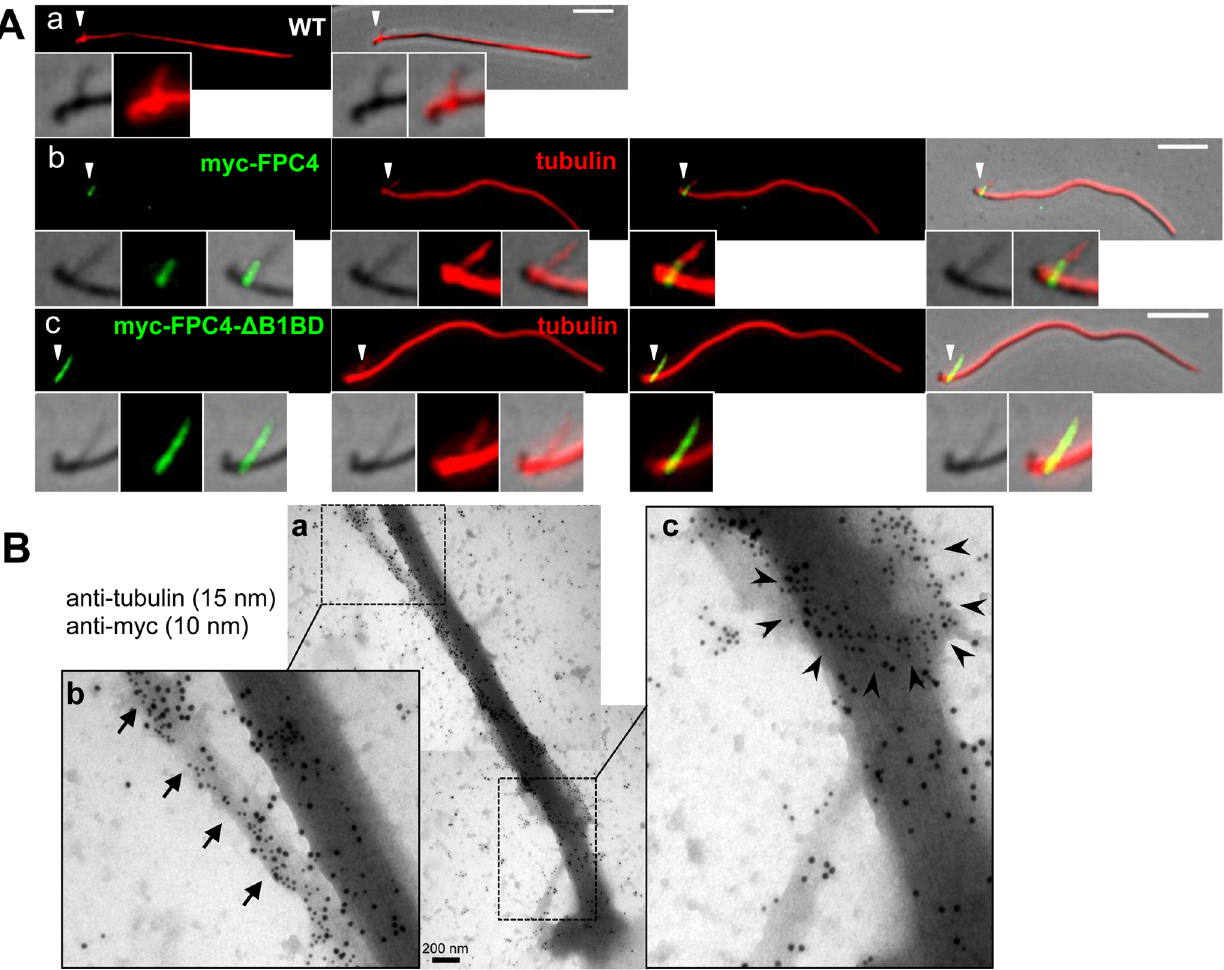
Fig 8. FPC4 binds to the remnant MtQ complex of isolated flagella. (A) Co-labellingof myc-taggedproteins (green) and tubulin (red) on isolated flagellafrom WT cells (a), and cells over-expressing myc-FPC4 (b) or myc-FPC4- Δ B1BD(c). White arrowheadsare pointing to the zoom areas. Scale bars 5 μ m. (B) Immuno-gold labellingof myc-FPC4- Δ B1BD(anti-myc, 10 nm gold beads) and tubulin (15 nm gold beads) on isolated flagella. In the zoom image (b), the arrows highlightthe MtQ decoratedwith anti-tubulinand anti-myc labellingthat appearsclose to the MtQ. In the zoom image (c), the black arrowheads highlightthe FPC structure decoratedby the anti-myc antibody.All the experiments were performed more than three independenttimes.